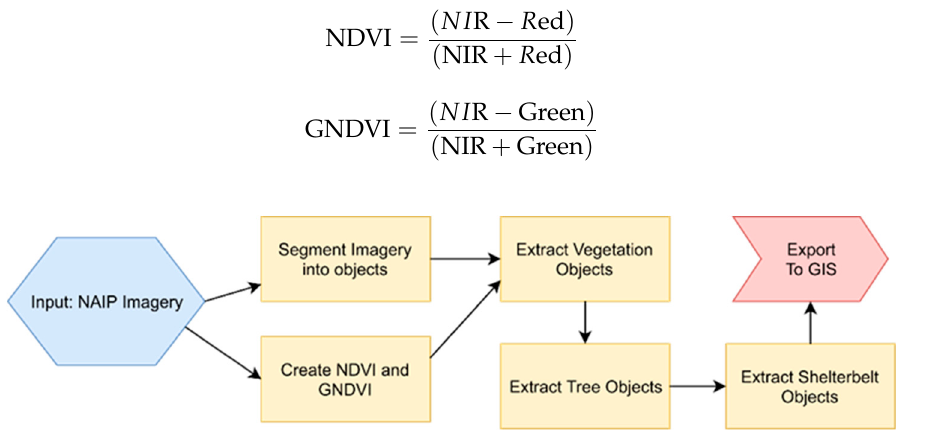
Figure 3. Geographic Object-Based Image Analysis workflow model to extract shelterbelts from National Agriculture Imagery Program imagery.